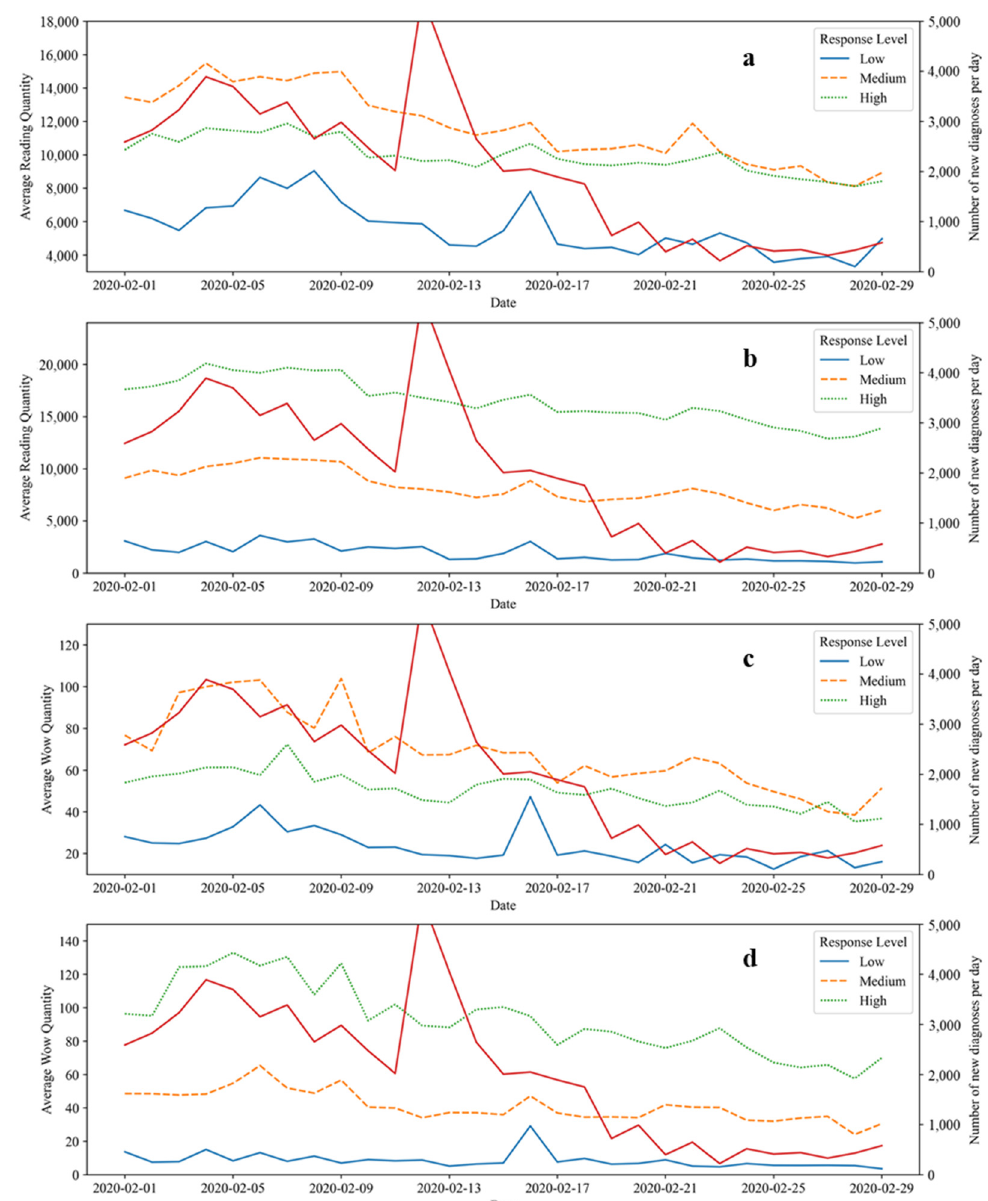
Figure 3. Diurnal variation of risk communication effects under different emergency response levels. Note: The unindicated point in the daily number of new diagnoses of the COVID-19 in China is 15,152 new cases on 12 February 2020. ( a ) The variation of ARQ on the classification of NA. ( b ) The variation of ARQ on the classification of NP. ( c ) The variation of AWQ on the classification of NA. ( d ) The variation of AWQ under time dimension on the classification of NP.